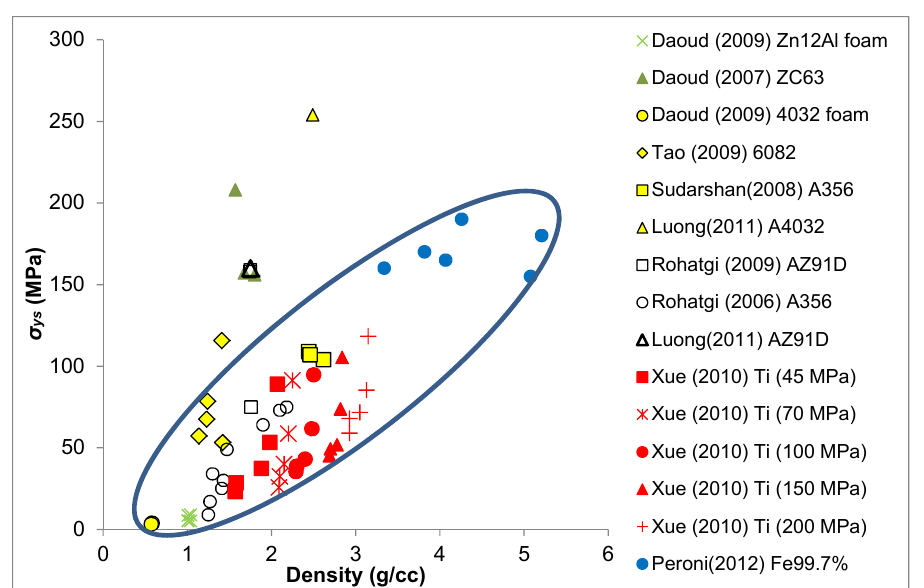
Figure 10. Comparison of yield strength of magnesium, aluminum, zinc, and titanium matrix syntactic foams. In the legend the nomenclature refers to the last name of the first author (year) alloy type (processing pressure, if used as a parameter in the composite